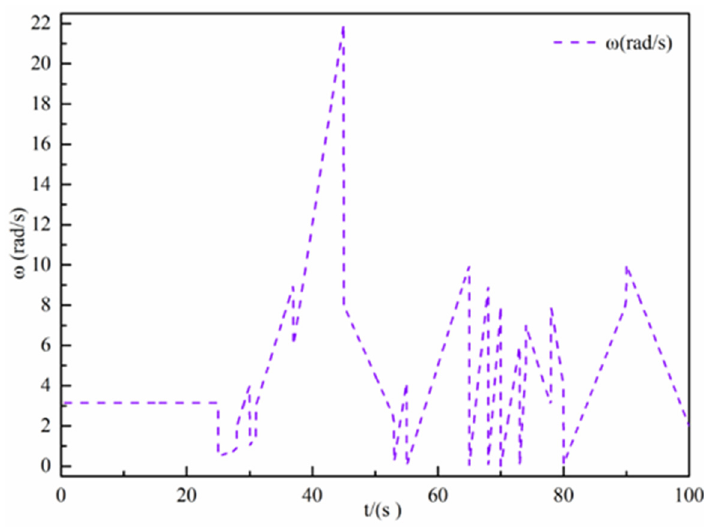
Figure 2. The rotational speeds of the rotating drum.